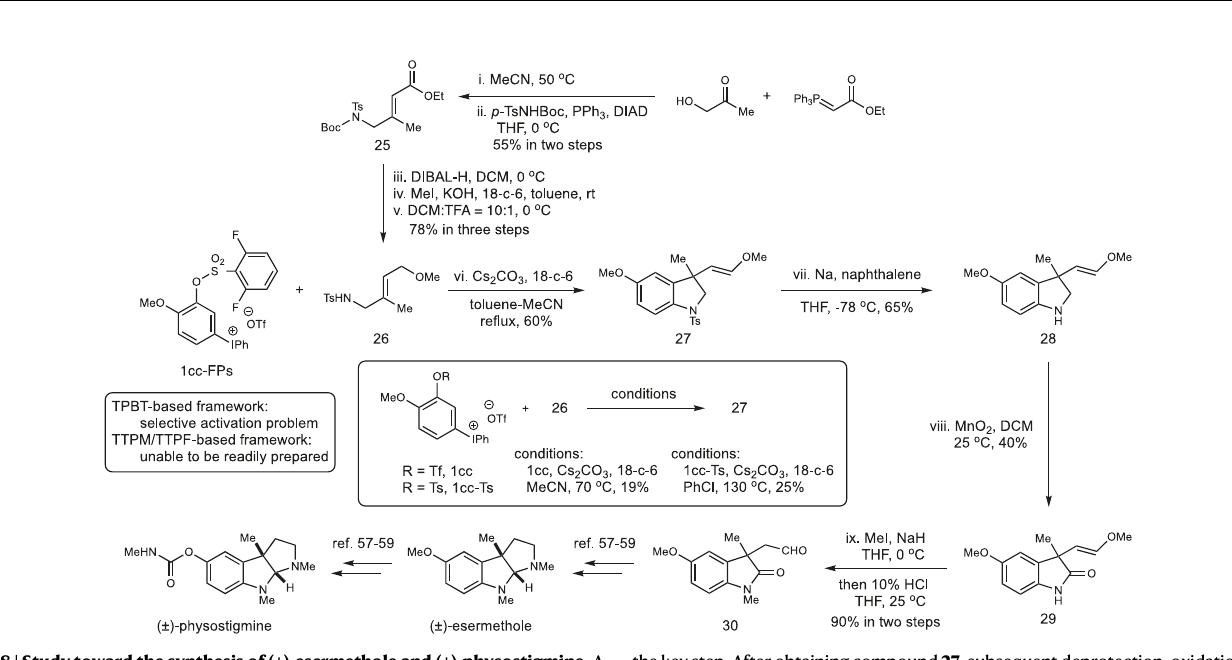
thekeystep.Afterobtainingcompound 27 ,subsequentdeprotection,oxidation,N- methylation, and conversion of the enol methyl ether to aldehyde gave rise to the desired compound 30 . Isolated yields are